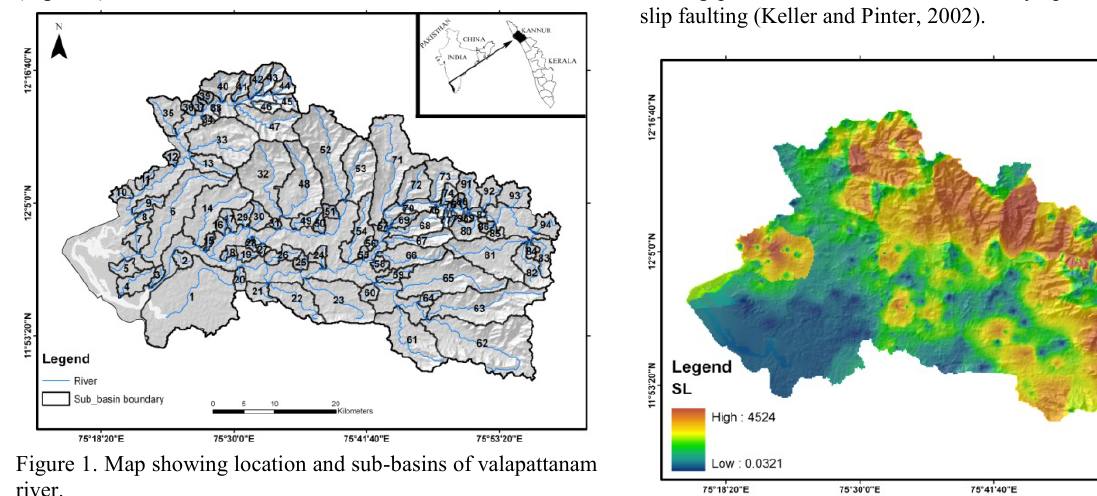
Figure 2. Spatial distribution of SL